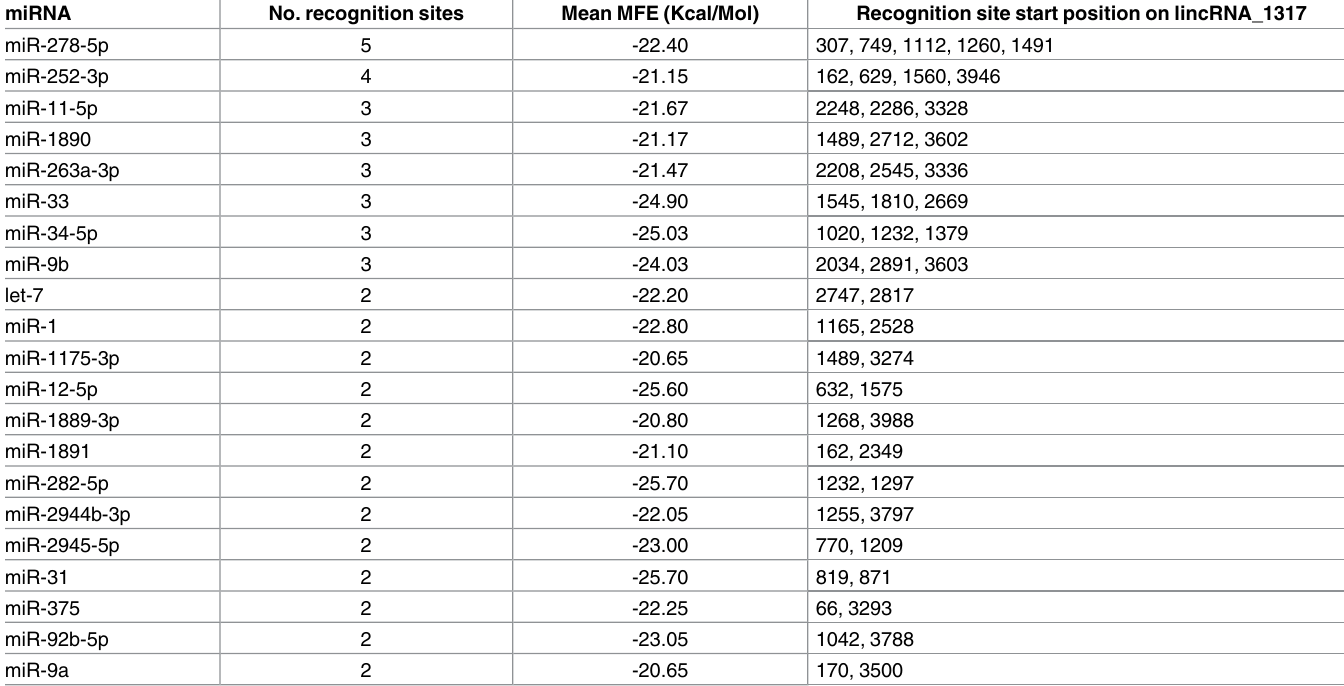
Table 2. Ae . aegypti miRNA recognition site distribution on